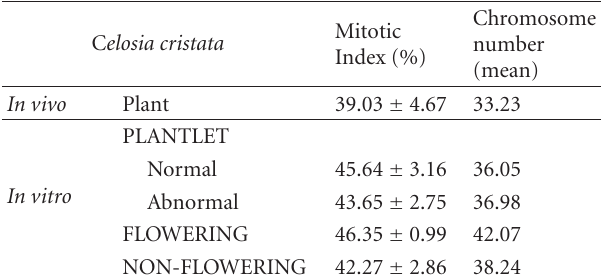
Table 2: The Mitotic Index and mean chromosome numbers in meristem cells of intact Celosia cristata plants and regenerants.